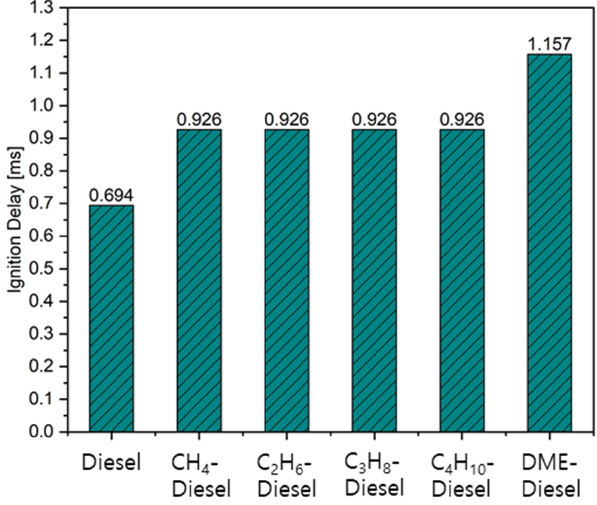
Figure 18. Ignition delay time in all combustion cases